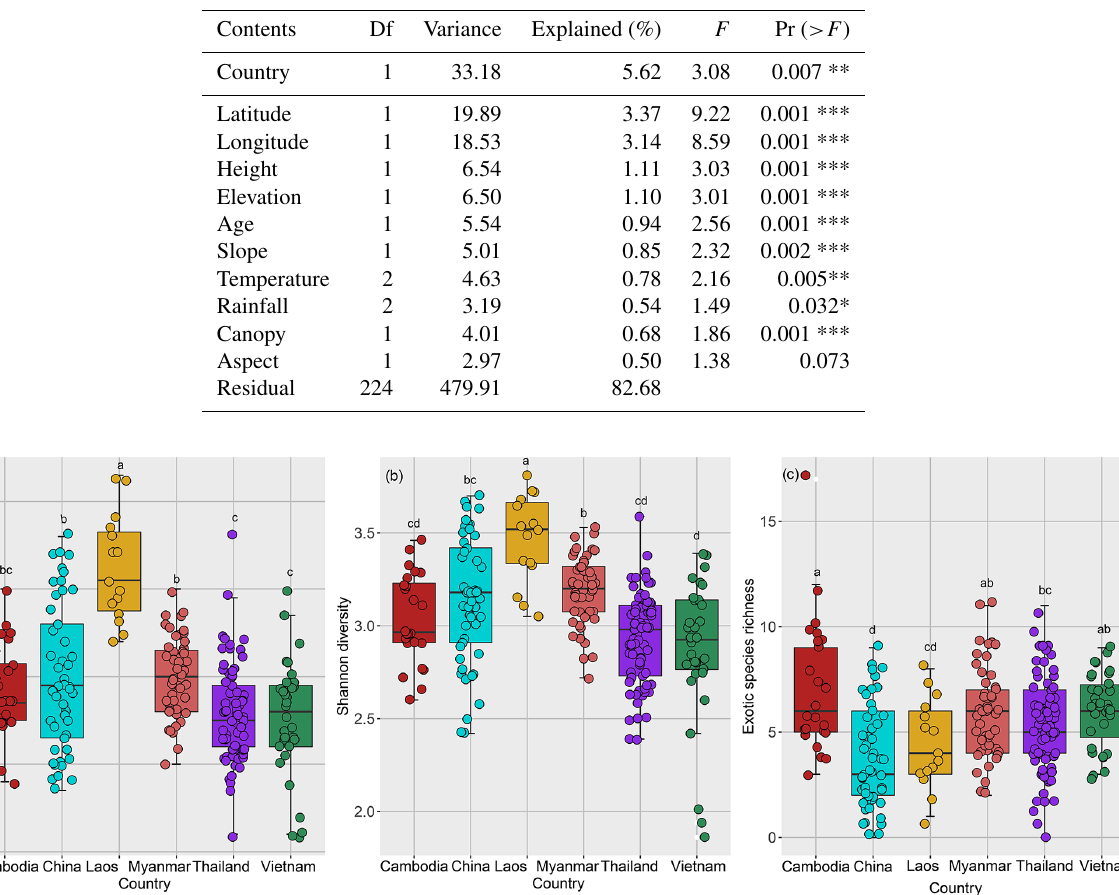
Table 2. Explained percentage of environmental factors on the variation of plant community compositions of rubber plantations in the GMS based on the RDA results.